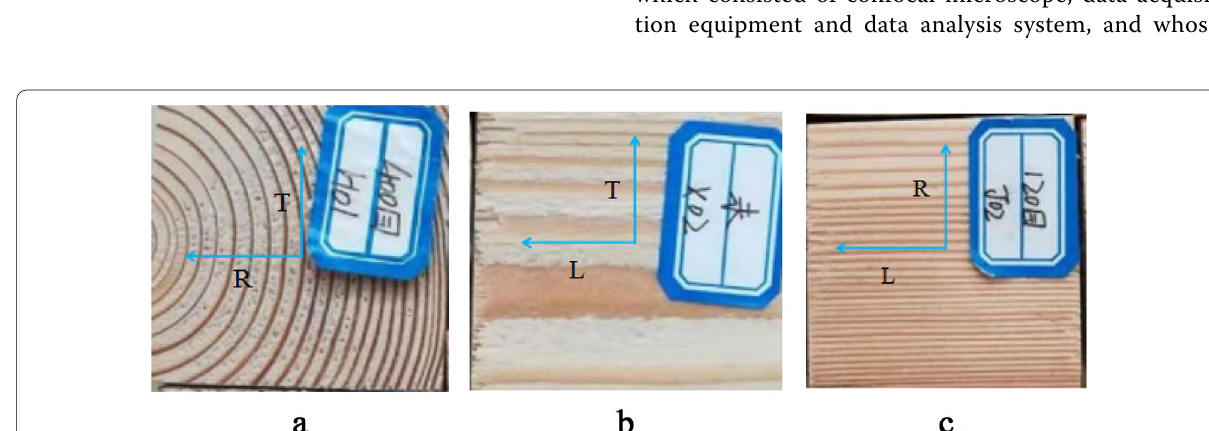
Fig. 7 Surface of samples: a transverse section; b tangential section; c radial section